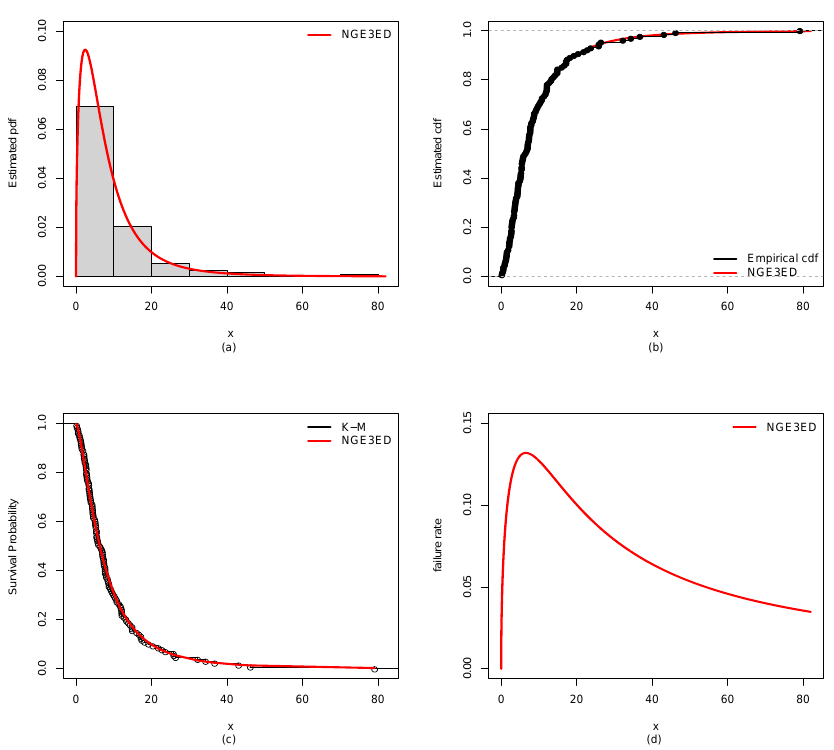
Figure 10. Estimated ( a ) pdf, ( b ) cdf, ( c ) Kaplan–Meier (K-M), ( d ) hazard rate for bladder-cancer